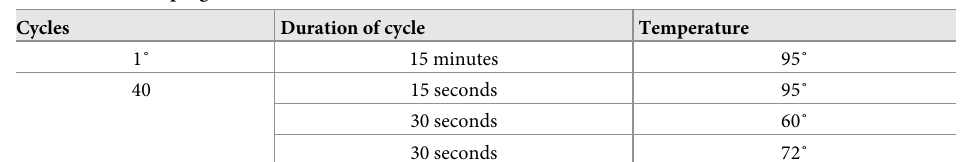
(AMPLIQON, Denmark) in a three-step PCR program and a total 20 reaction volumes were performed on Real-Time PCR system (Roche Life Sciences, Germany). Relative expression of examined genes was quantified and normalized by b-actin as the internal control gene. Also, conditions used of PCR and upstream and downstream primers were respectively described in Tables 2 and 3.